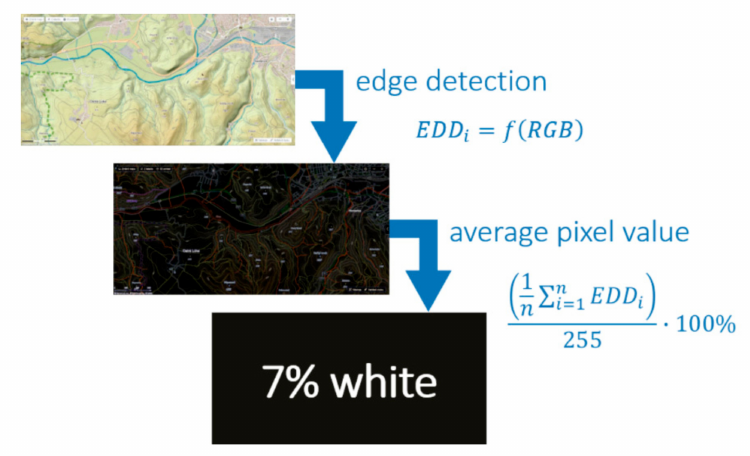
Figure 4. Principle of the ED1